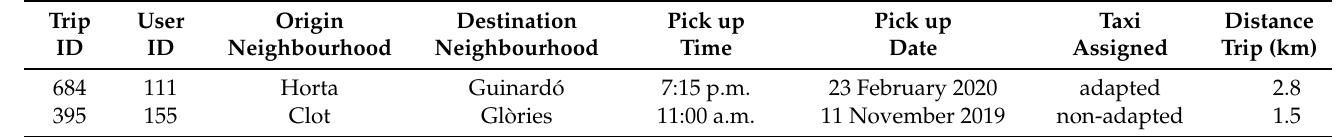
Table 2. Examples of the dataset structure of the trips made with the SMTS. It contains information about trip identifier, user identifier, origin and destination neighbourhood of the trip, taxi pickup time and date, assigned taxi (adapted or nonadapted), and trip